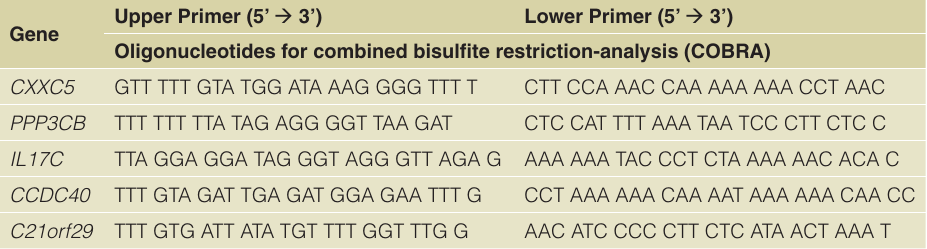
Supplementary Table 1. Oligonucleotide